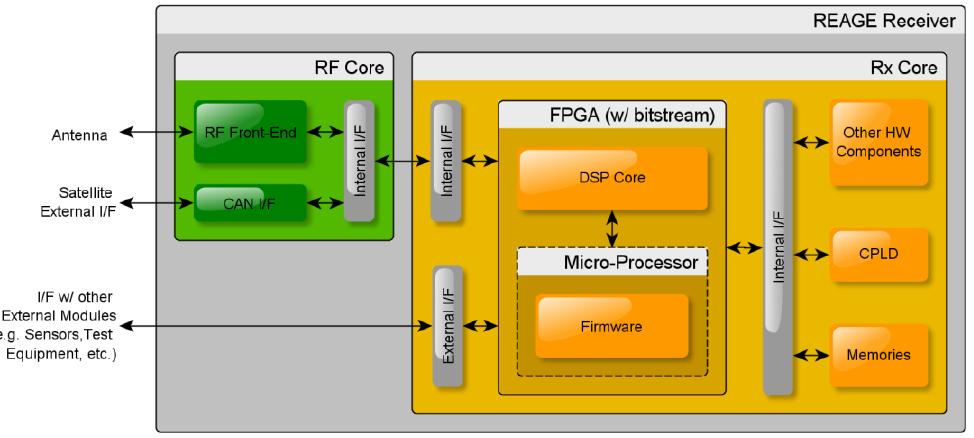
Figure 1. REAGE receiver